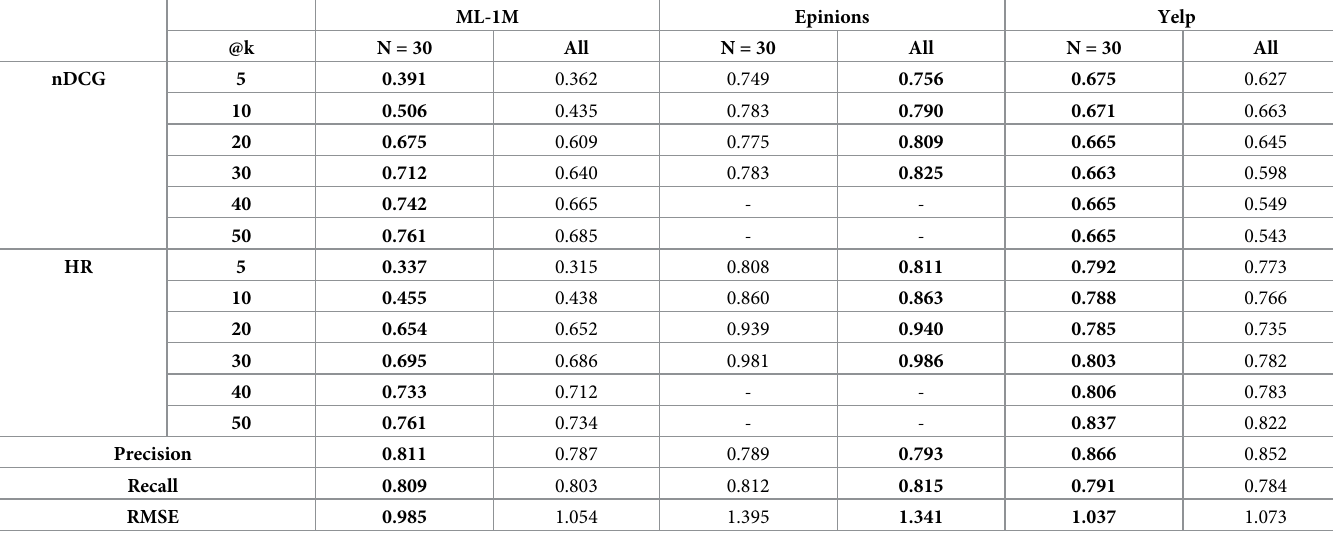
Table 8. The experimental results of using N neighbor and all neighbor.